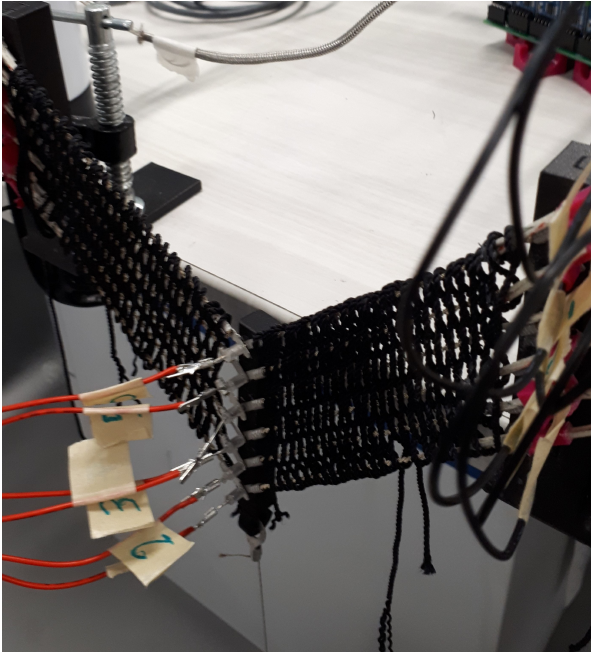
Figure 4. Actuator configuration for the stroke characterisation